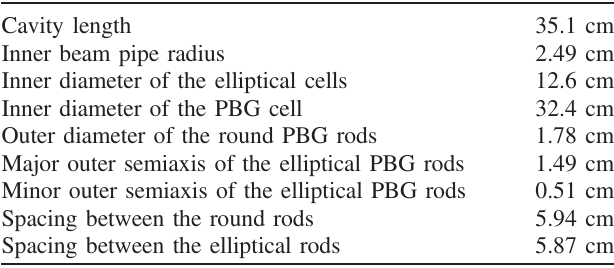
TABLE I. Dimensions of the five-cell cavity with a PBG cell.